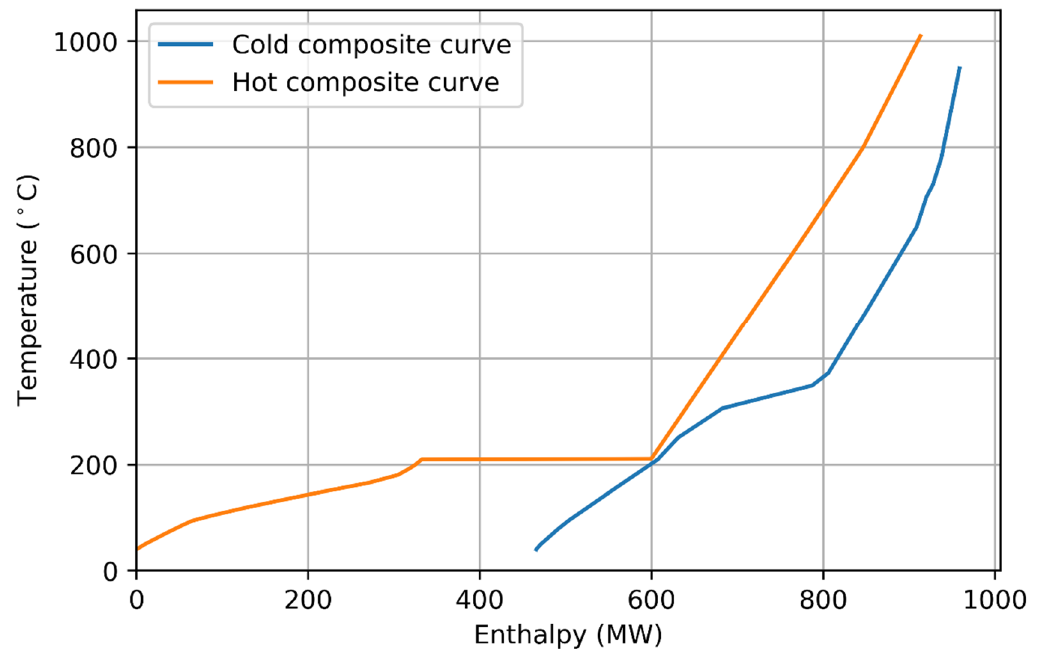
Figure 10. Composite curves for the staged biogas to liquid process. The process requires 466 MW and 45 MW of external cooling and heating, respectively.